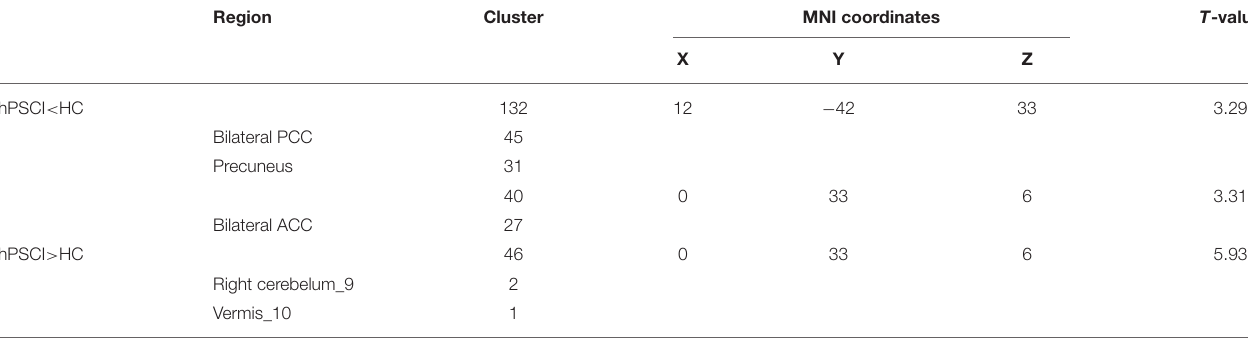
TABLE 2 | Comparisons of fALFF between cognitive impairment group after hemorrhagic stroke (hPSCI group) and healthy control group (HC group). Region Cluster MNI coordinates T -value X Y Z hPSCI < HC 132 12 − 42 33 3.29 Bilateral PCC 45 Precuneus 31